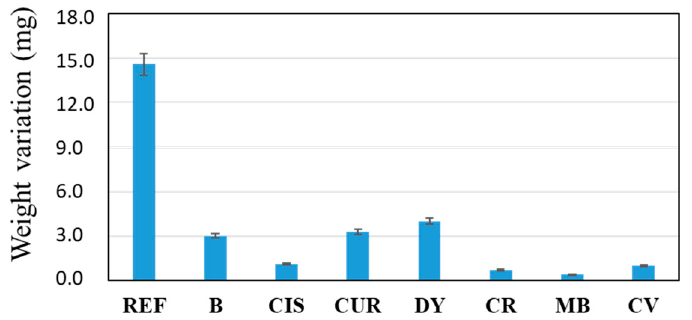
Figure 5. Difference in weight of samples before and after the corrosion Figure 5. Di ff erence in weight of samples before and after the corrosion test.